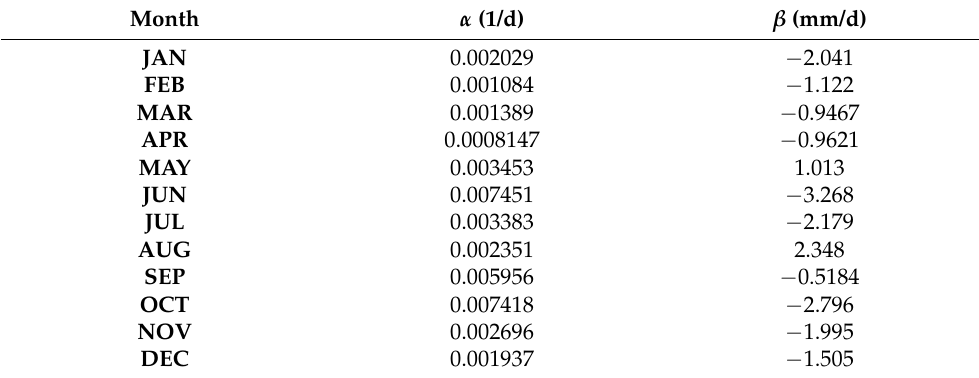
Table 3. Coefficients of linear regression between elevation and mean monthly daily precipitation average for each month.